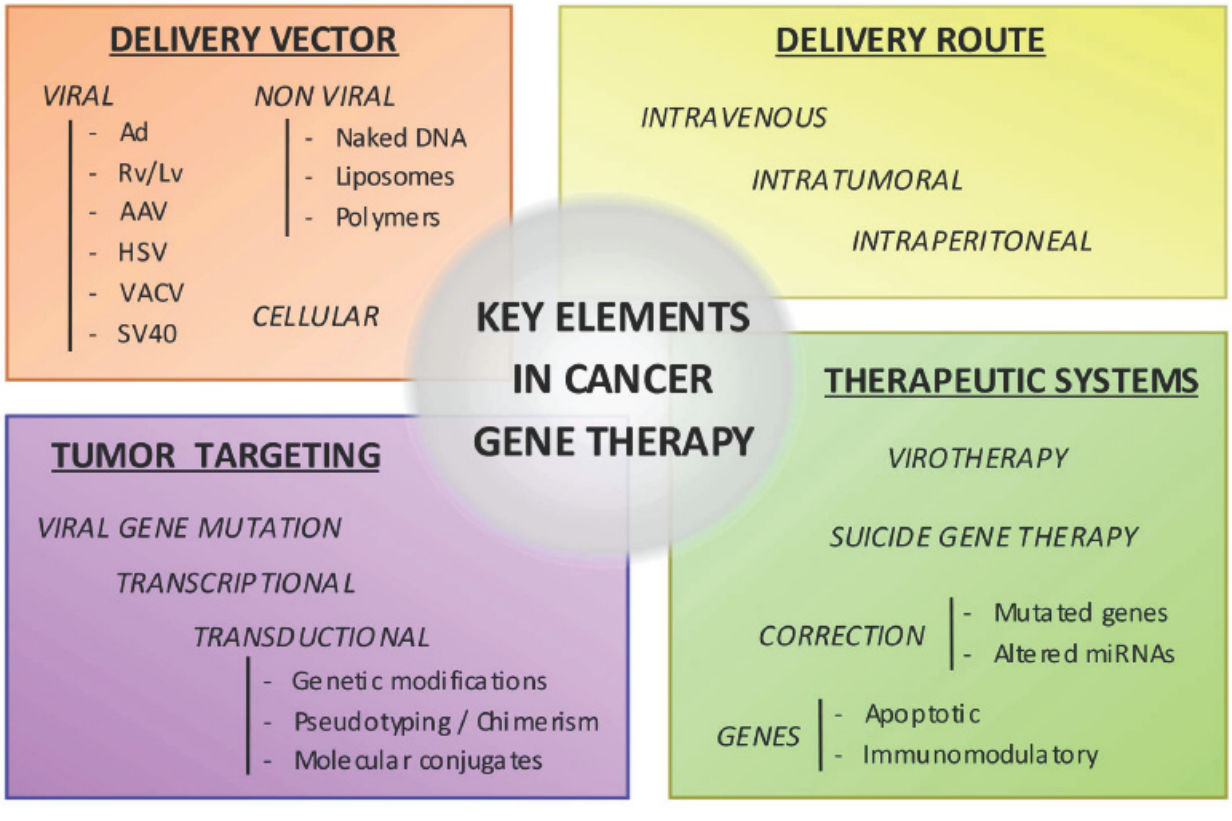
Figure 1. Key factors in the development of gene